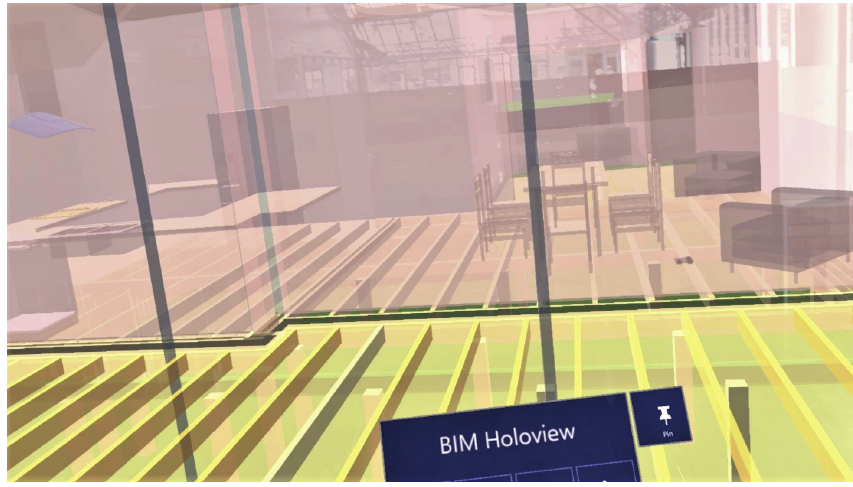
Figure 1. Student view of construction plans with the Bimholoview app on HoloLens 2 at Toi Ohomai / Te P ū